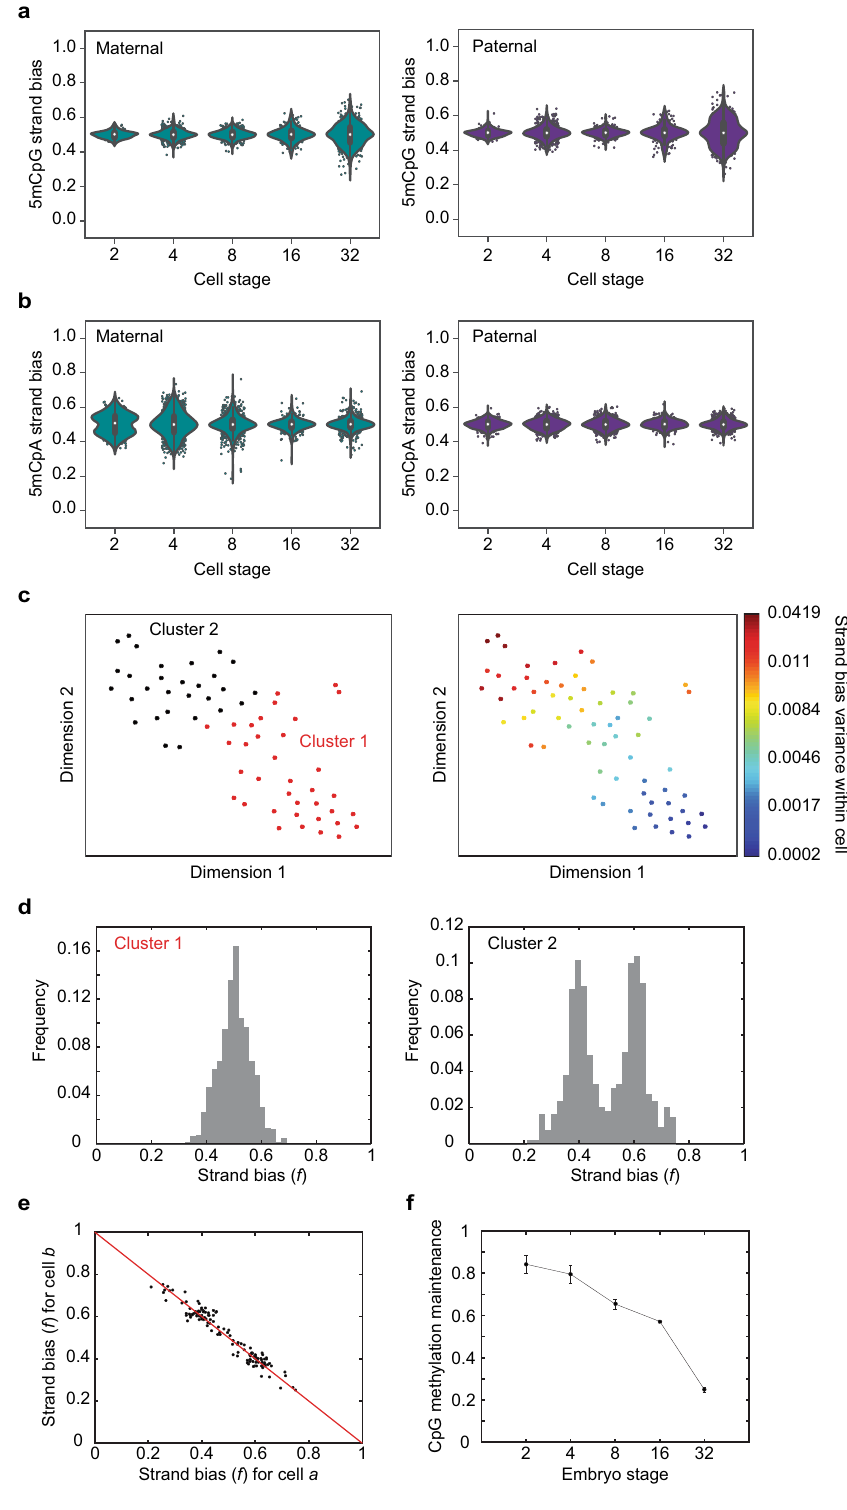
We fi nally extended scMspJI-seq to explore the dynamics of initial phase till the 16-cell stage displaying a tight 5mCpG global demethylation in human preimplantation embryos, strand-bias distribution centered around 0.5, followed by an ranging from developmental day 2 to 7. Studies in human increase in strand bias in a small fraction of cells from the 32- to preimplantation embryos have shown temporally slower, yet 128-cell stage (Fig. 5a and Supplementary Fig. 10a). This is similar developmental dynamics to mouse embryos 39 . Despite consistent with previous immunostainings in human preimplan- lacking allelic information, our results suggest that the mouse and tation embryos that show a decrease in DNMT1 protein levels human 5mCpG demethylation dynamics are similar, with an between day 5 and day 6 blastocysts 40,41 . Further, 5mCpA strand- NATURE COMMUNICATIONS| (2021) 12:1286